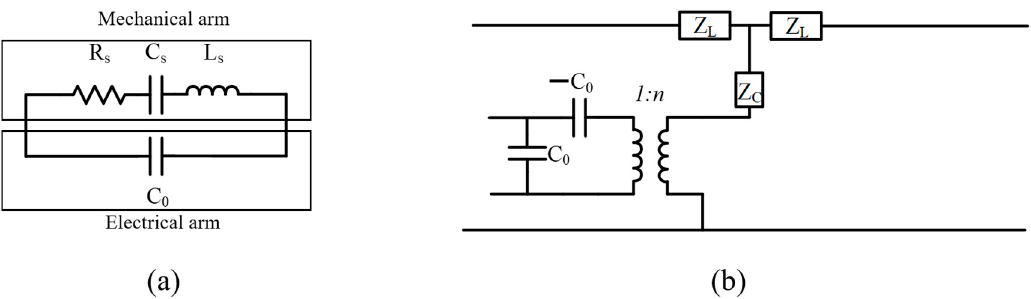
Figure 1. Equivalent circuit of transducer. ( a ) BVD model, ( b ) Mason model. R S represents radiation and mechanical losses of the transducer. C s and L s model its resonant behavior, and then f r can be calculated by Equation (1)